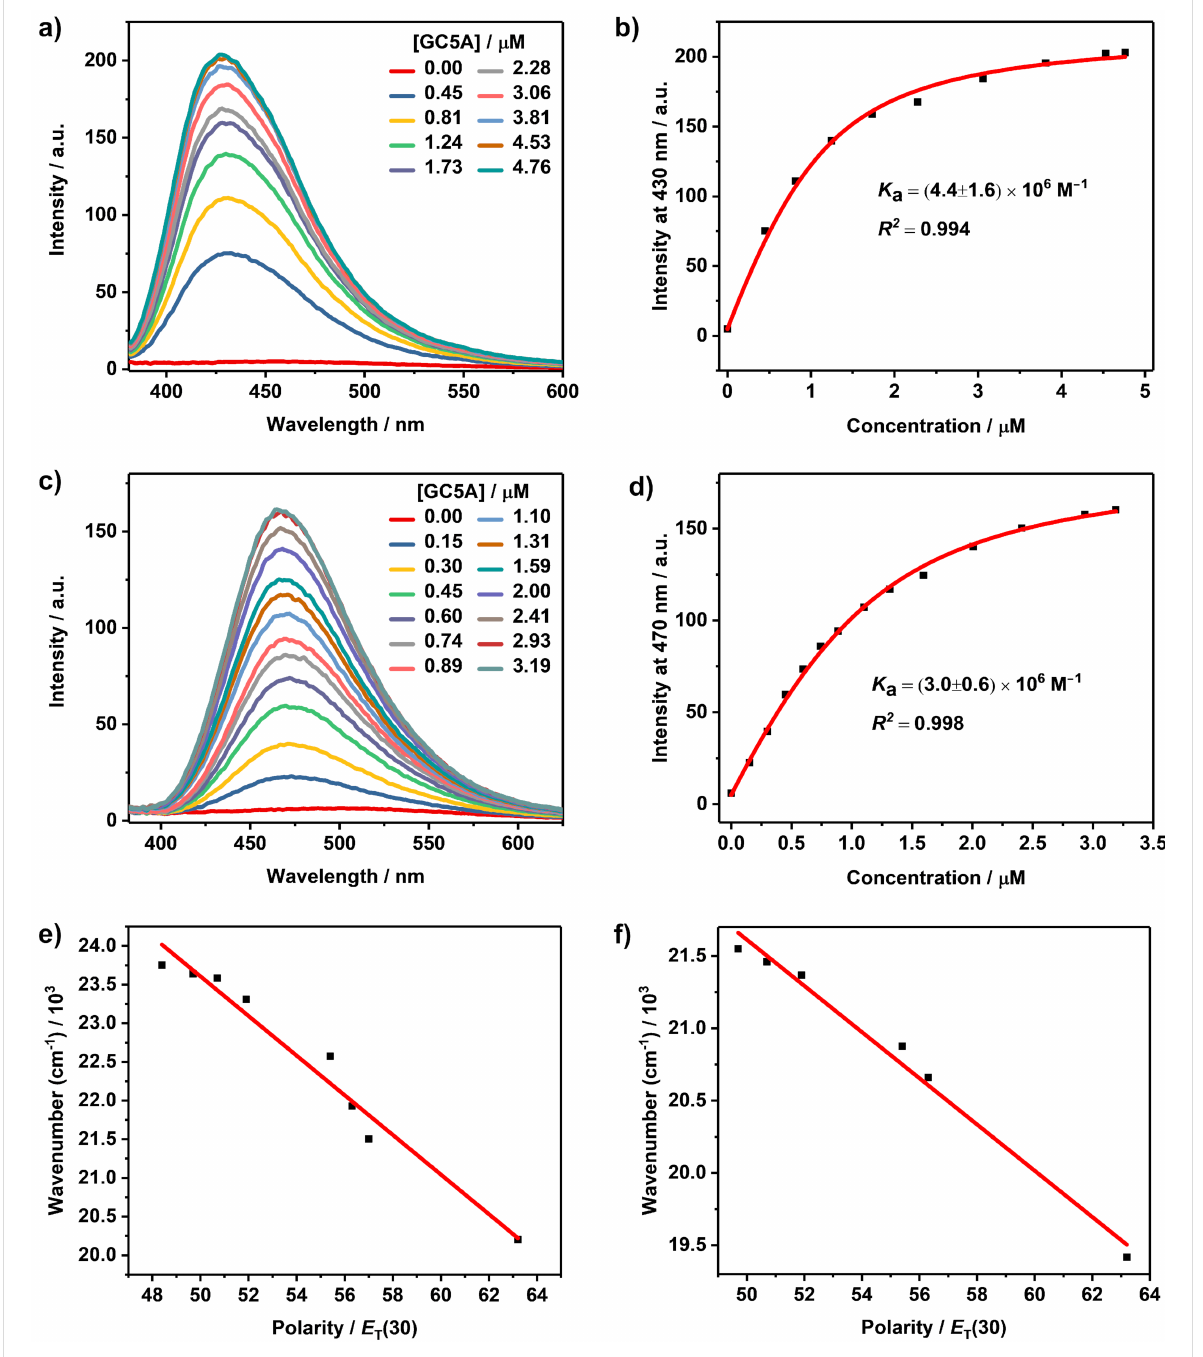
Figure 1: Direct fluorescence titrations ( λ ex = 350 nm) of 2,6-TNS (1.0 μ M) (a) and 1,8-ANS (1.0 μ M) (c) with GC5A in HEPES buffer (10 mM, pH 7.4) at 25 °C and the associated titration curves of 2,6-TNS ( λ em = 430 nm) (b) and 1,8-ANS ( λ em = 470 nm) (d) fitting according to a 1:1 binding stoichi- ometry. Emission wavenumbers of 2,6-TNS (e) and 1,8-ANS (f) in different solvents as a function of the E T (30) polarity scale.